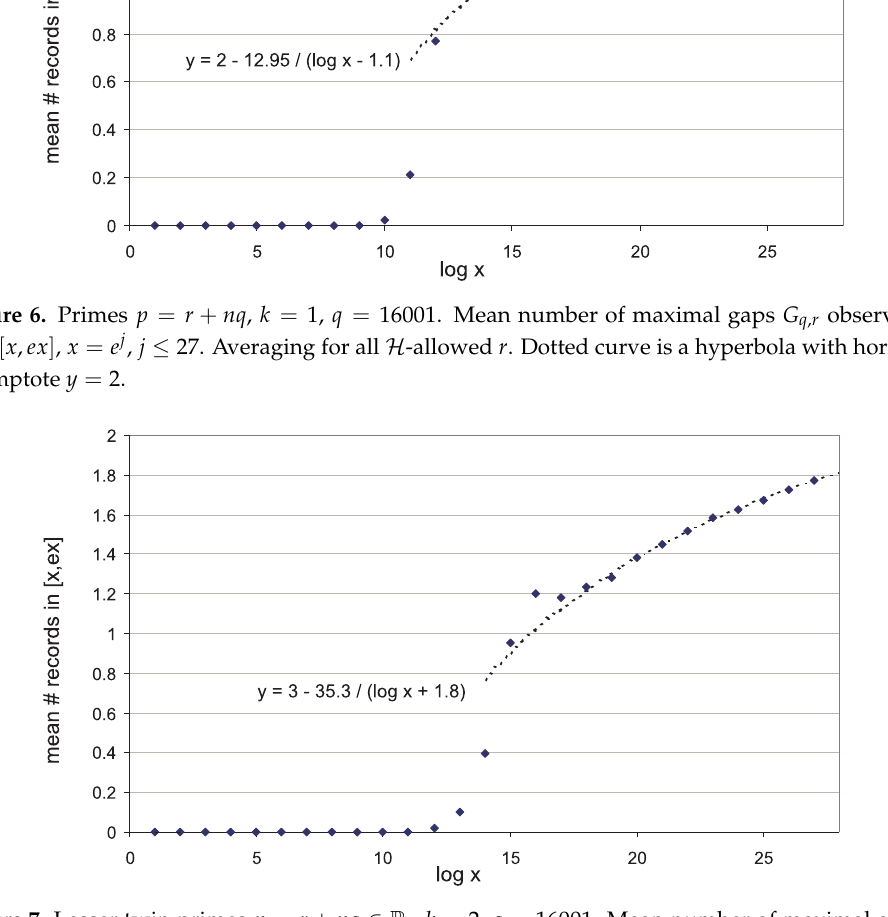
Figure 7. Lesser twin primes p = r + nq ∈ P c , k = 2, q = 16001. Mean number of maximal gaps G c observed for p ∈ [ x , ex ] , x = e j , j ≤ 27. Averaging for all H -allowed r . Dotted curve is a hyperbola with horizontal asymptote y =